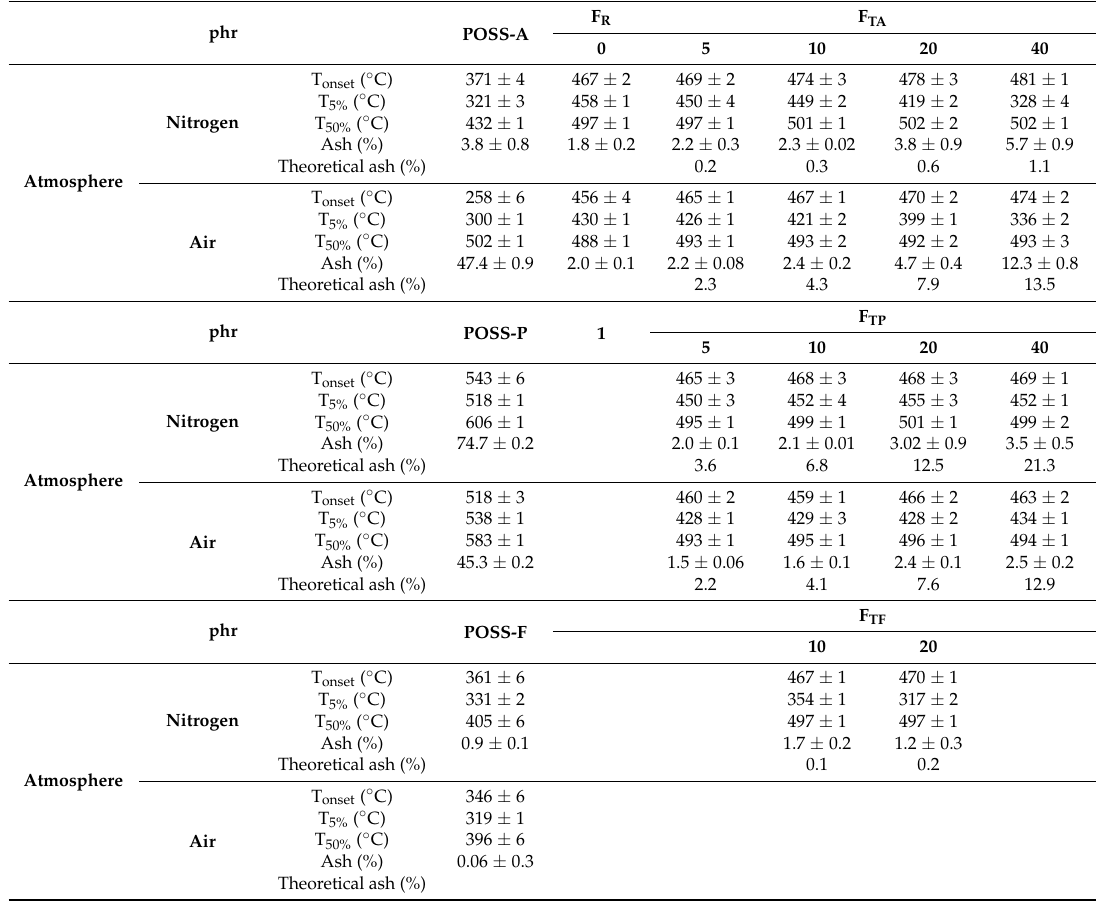
Table 2. Summary of TGA results for POSS fillers and